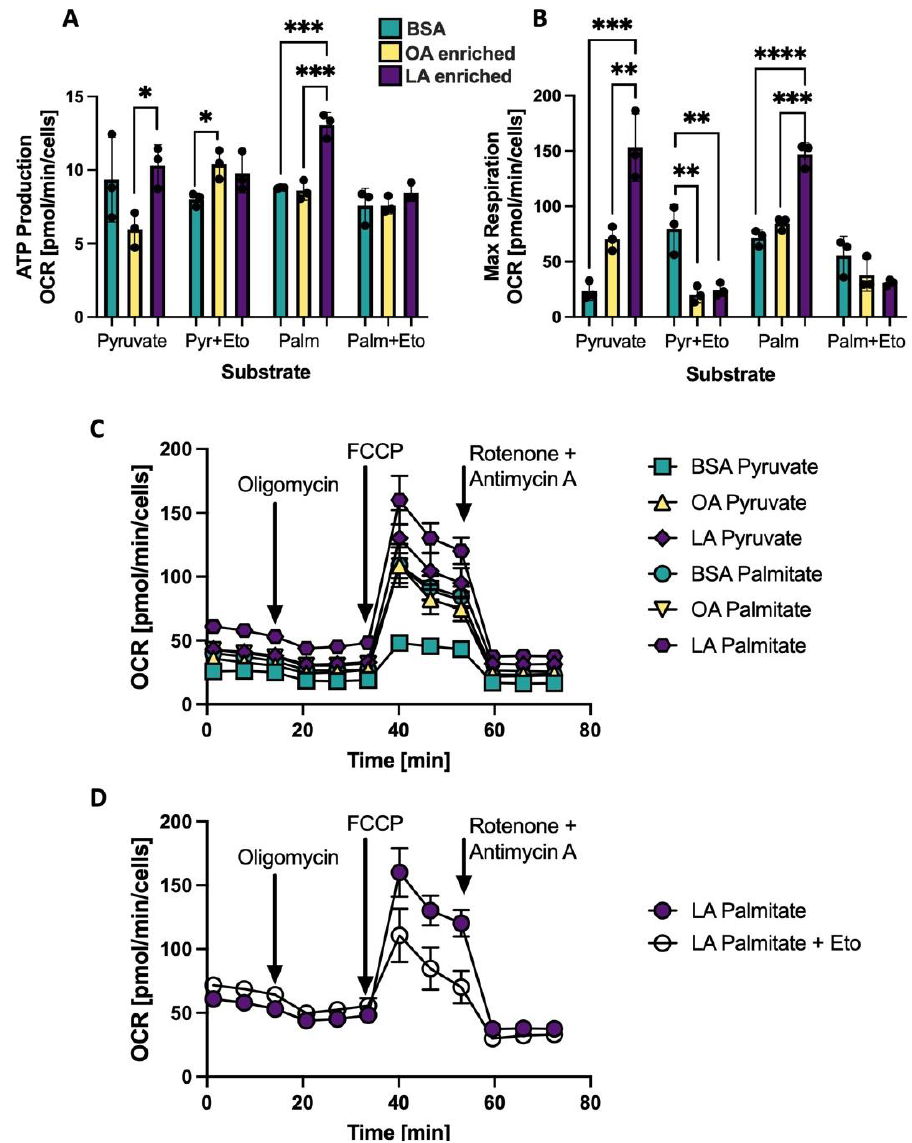
Figure 6. Mitochondrial oxygen consumption rate (OCR) is shifted depending on CL composition and substrate composition. ( A ) ATP Production OCR using either pyruvate (Pyr) or palmitate (Palm) as a substrate with and without the CPT inhibitor etomoxir (Eto) in NRVMs treated with BSA, OA enriched or LA enriched for 48h to alter CL composition. ( B ) Maximal respiration same conditions as ( A ). ( C ) Representative Seahorse spectra for the samples without Eto. ( D ) Representative Seahorse spectra in LA enriched cells using palmitate as a substrate with and without Eto. * p < 0.05, ** p < 0.01, *** p < 0.001, **** p < 0.0001; N = 3 separate Seahorse plates from separate NRVM preparations. Error bars represent standard error of the mean.